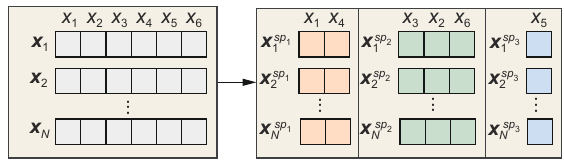
Fig. 2 Example of problem